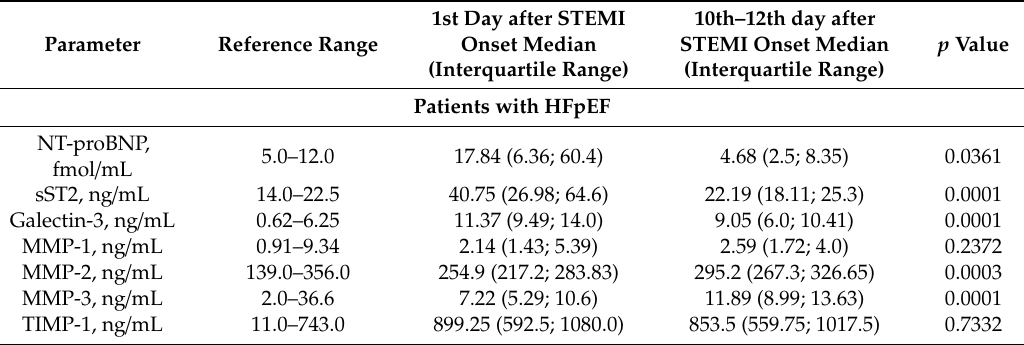
Table 5. Serum concentrations of biomarkers in patients diagnosed with ST-segment elevation myocardial infarction with preserved ejection fraction (HFpEF, n = 100) and ST-segment elevation myocardial infarction with reduced ejection fraction (HFrEF, n = 154) at the time of admission and